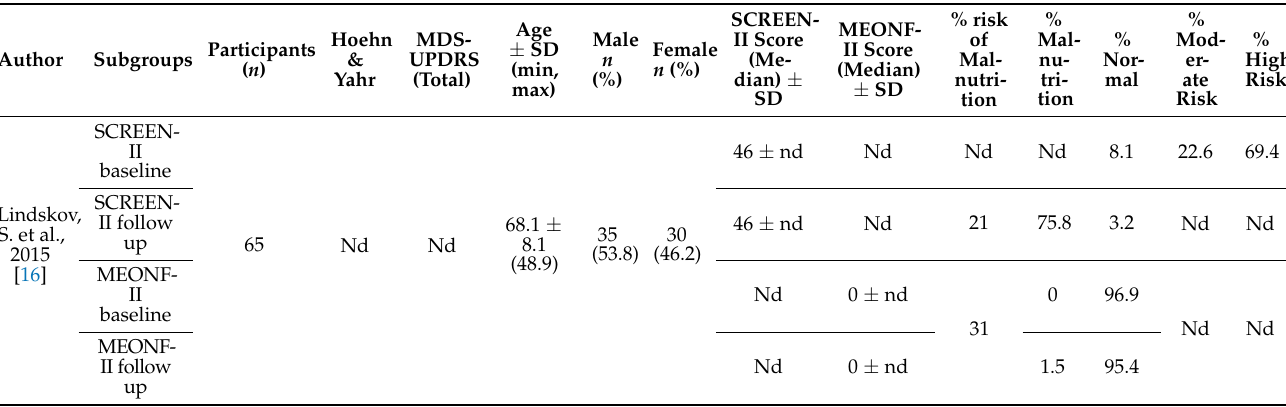
Table 7. SCREEN-II and MEONF-II.